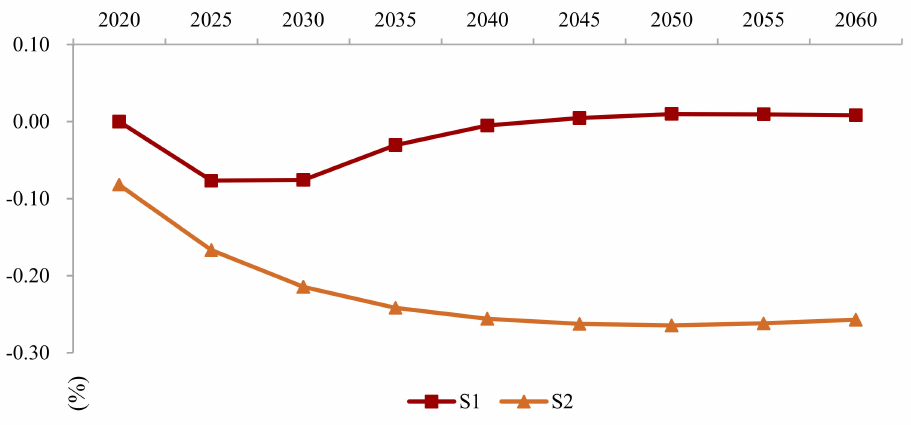
Figure 8. The GDP loss under S1 and S2 scenario compared with the BAU